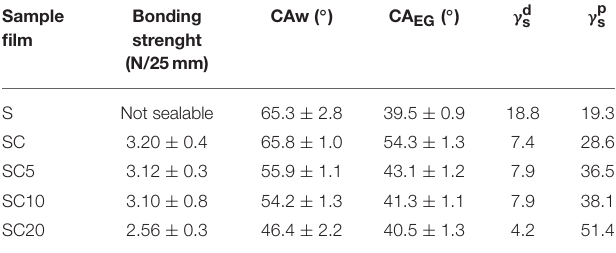
TABLE 2 | Bonding strenght (N/25mm), static water (CAw), and ethylene glycol (CA EG ) contact angles, and dispersion ( γ d s ) and polar ( γ p s ) components of the surface energy for the neat PET substrate film (S) and for the SC coated films at 0, 5, 10, and 20% LAE concentration.